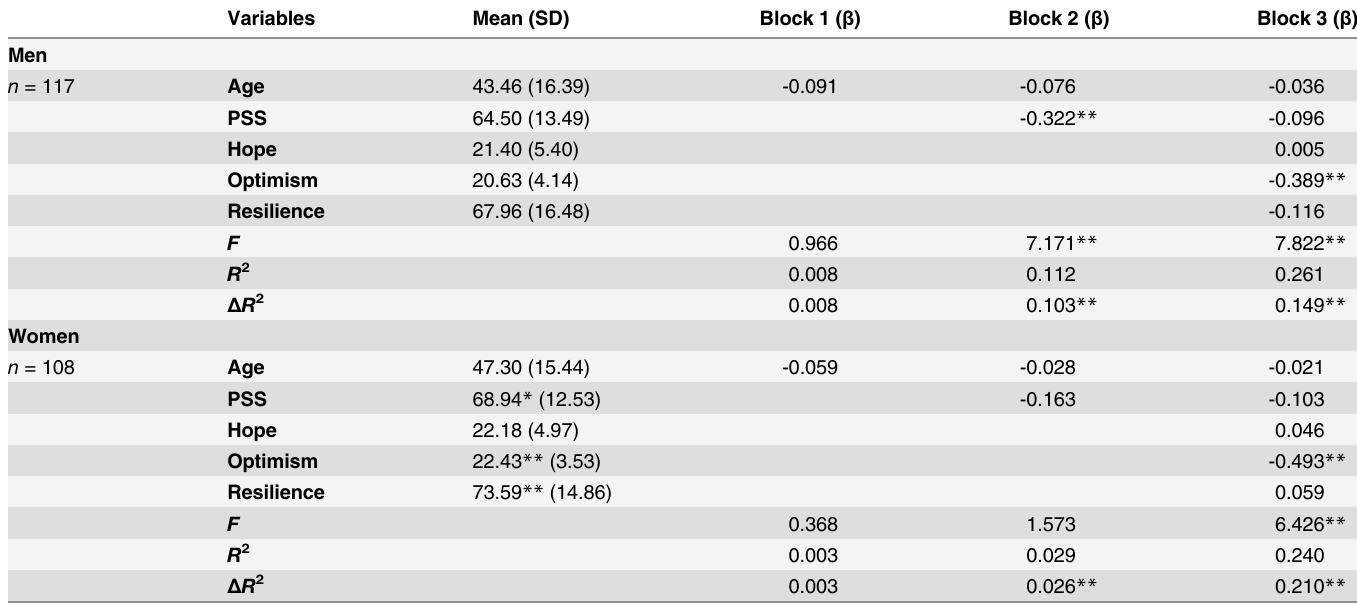
Table 5. Hierarchical regression for exploring the positive correlates of PTSD symptoms in men and women, respectively.